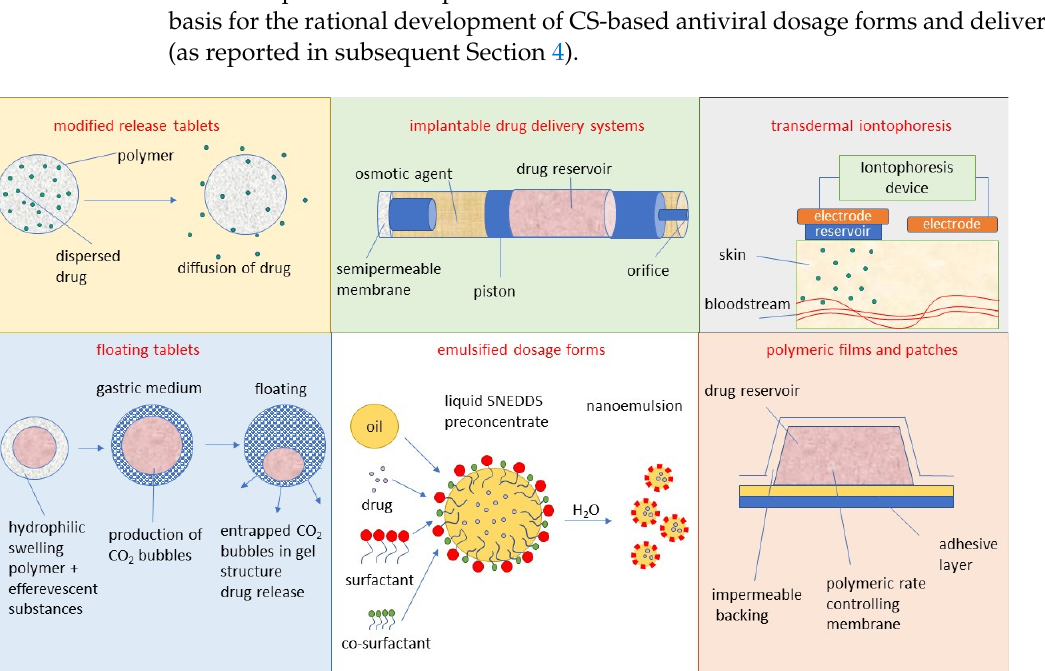
Figure 1. Selected innovative dosage forms for antiviral therapy ) .